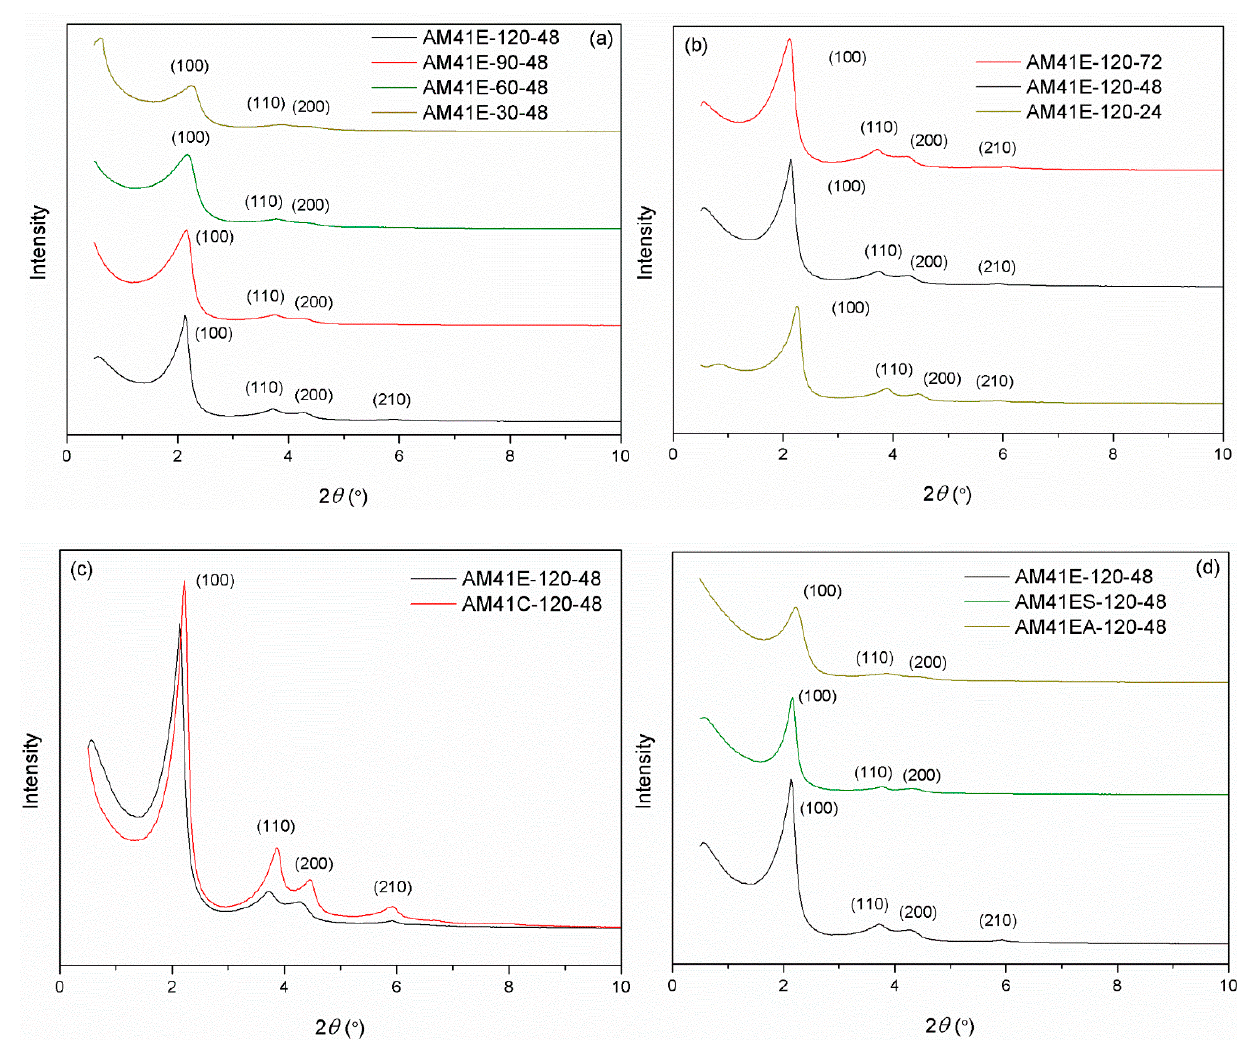
Figure 4 . SXRD patterns for ( a ) AM41E-120-48, AM41E-90-48, AM41E-60-48, and AM41E-30-48, ( b ) AM41E-120-72, AM41E-120-48, and AM41E-120-24, ( c ) AM41E-120-48 and AM41C-120-48, and ( d ) AM41E-120-48, AM41ES-120-48, and AM41EA-120-48.